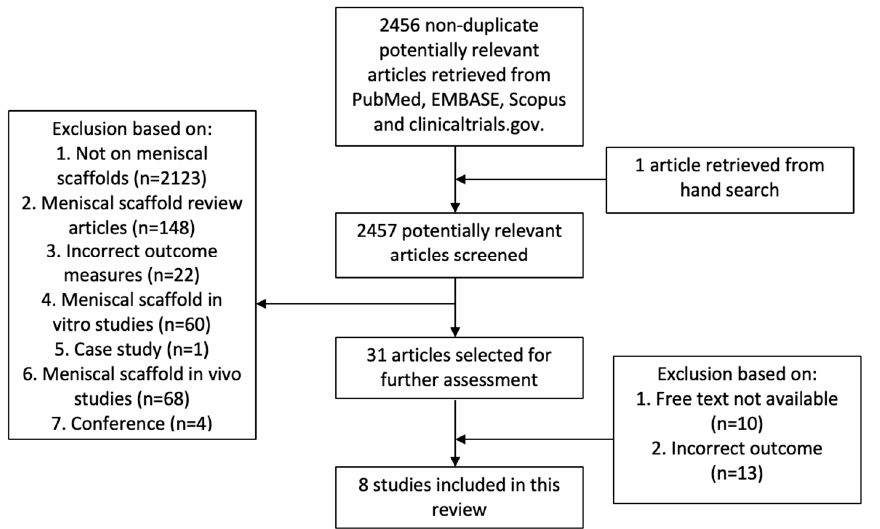
Figure 1. The study selection flow diagram.